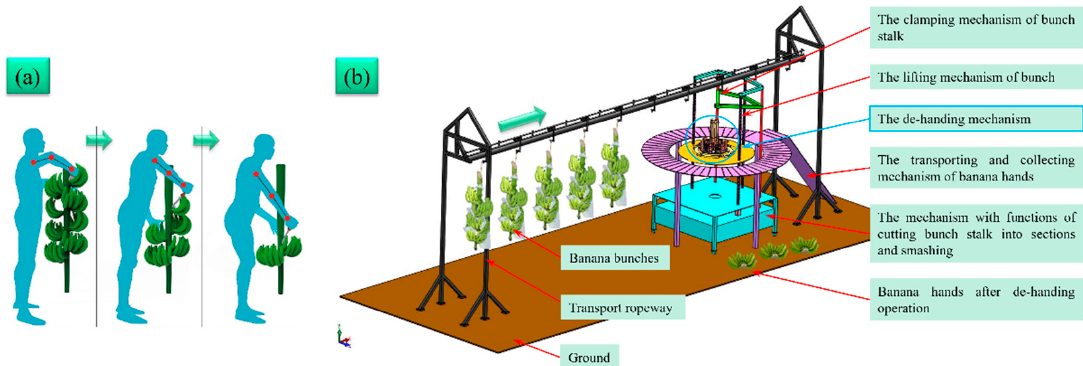
Figure 4. Schematic diagram of manual de ‐ handing [7] ( a ); and virtual prototype of mechanical de ‐ handing systems [8] ( b ).